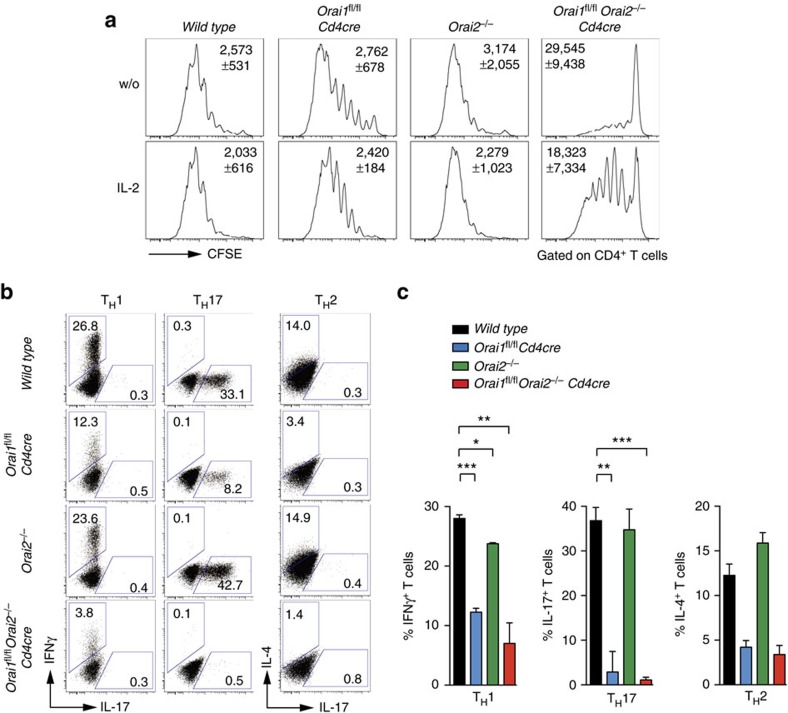
Impaired proliferation and cytokine production of Orai1/Orai2-deficient T cells in vitro.(a) CD4+ T cells isolated from WT, Orai1fl/flCd4cre, Orai2−/− and Orai1fl/flOrai2−/−Cd4cre (DKO) mice were stimulated with plate-bound anti-CD3/CD28 for 4 days in vitro with or without 50 U ml−1 recombinant human IL-2 (rhIL-2). Proliferation was analysed by CFSE dilution using flow cytometry; mean fluorescence intensity (MFI)±s.e.m. of CFSE from two to three experiments is shown within the histograms. Additional time points are presented in Supplementary Fig. 6. (b,c) Impaired TH1, TH17 and TH2 cytokine production in Orai1- and Orai1/Orai2-deficient T cells. (b) T cells isolated from WT, Orai1fl/fl
Cd4cre, Orai2−/− and DKO mice were differentiated for 3 days under TH1-, TH17- and TH2-polarizing conditions and intracellular IFNγ, IL-17 and/or IL-4 was analysed by flow cytometry after restimulation with phorbol myristate acetate (PMA)/ionomycin for 6 h. (c) Quantification of IFNγ, IL-17- and IL-4-positive T cells as shown in b; mean±s.e.m. from three independent experiments (TH1 and TH17) or two experiments (TH2). *P<0.05; **P<0.005; ***P<0.001 in (c) using unpaired Student's t-tests.